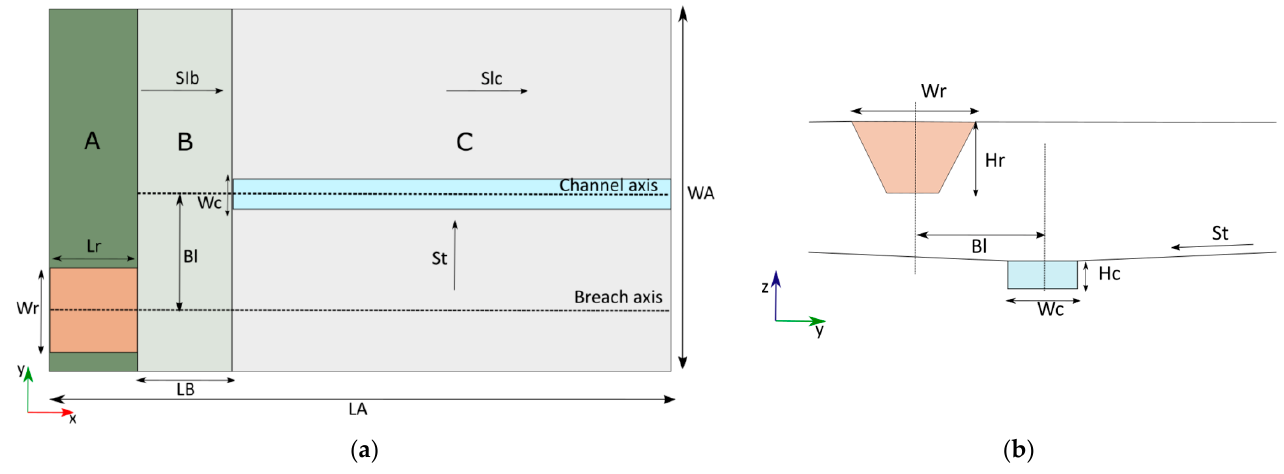
Figure 1. Synthetic geometry. ( a ) Floor plan view. ( b ) Frontal view.